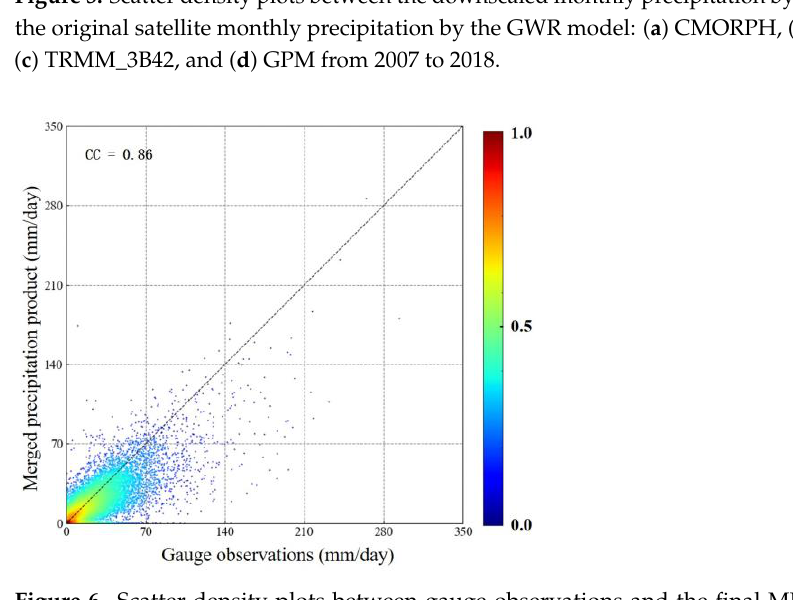
Figure 7. Spatial daily precipitation estimates from ( a ) the rain gauge observation, ( b ) the final MPP with 005° resolution, ( c1 ) the original 0.25° resolution TRMM_3B42, ( d1 ) the downscaled 0.05° resolution TRMM_3B42, ( c2 ) the original 0.25° resolution PERSIANN-CDR, ( d2 ) the downscaled